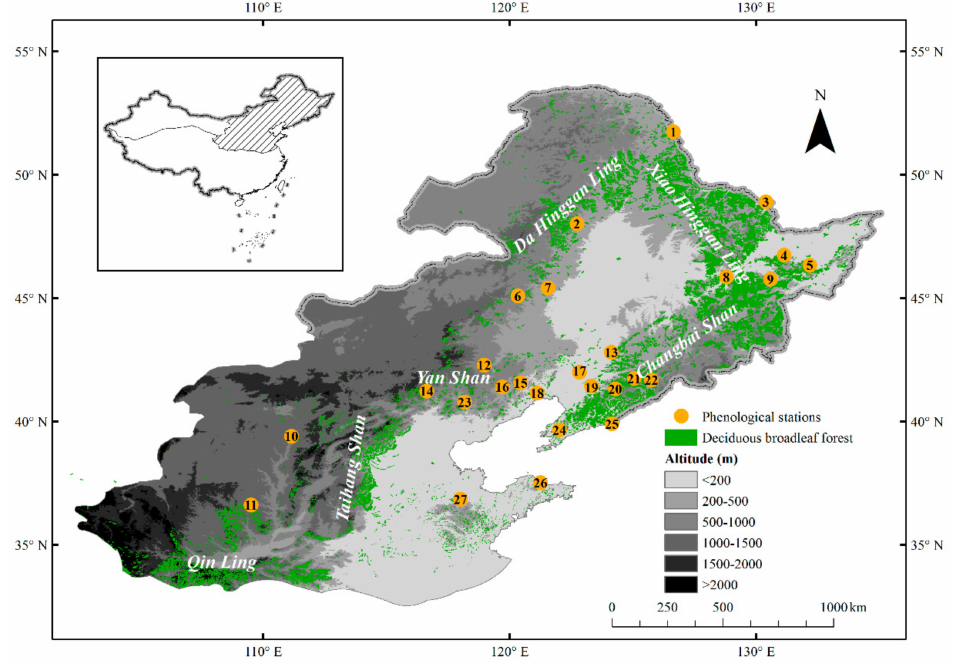
Figure 1. Distribution of temperate deciduous broadleaf forests and phenological observation stations in northeastern